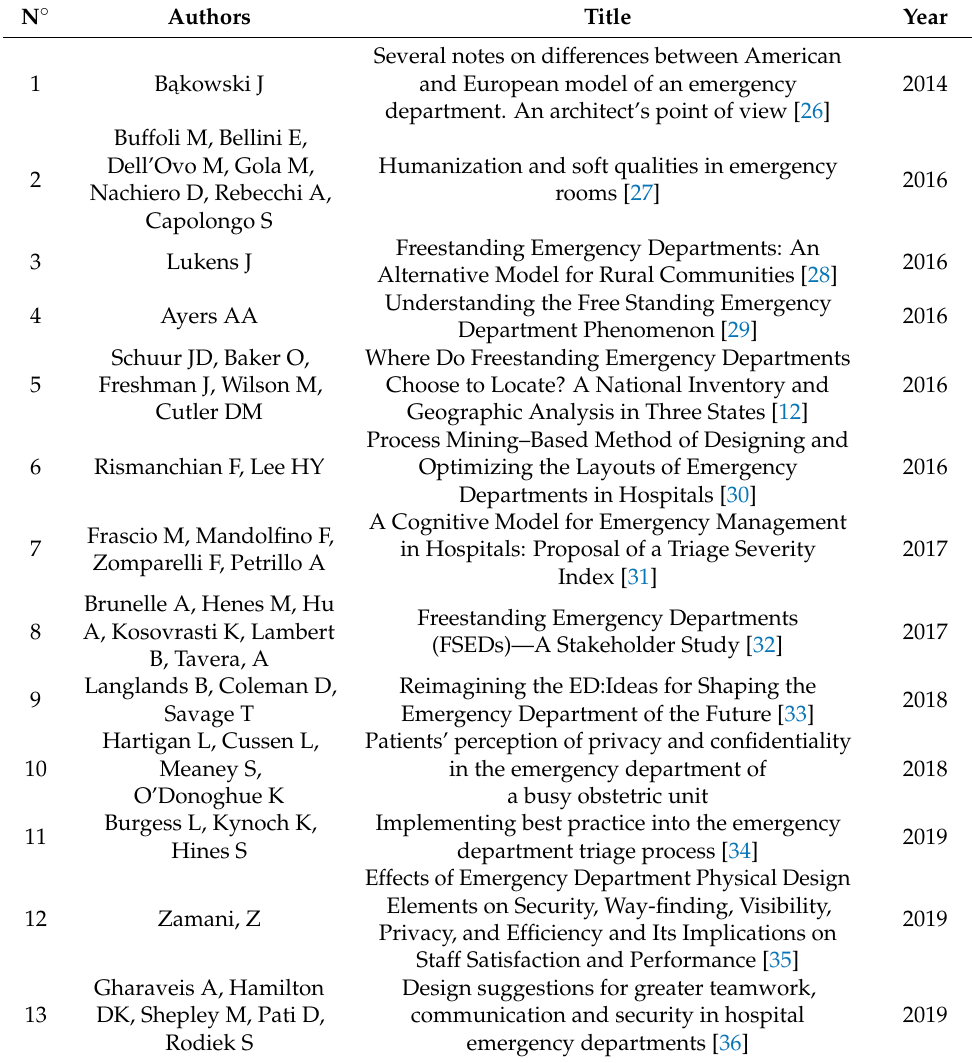
Table 2. Summary of the literature review